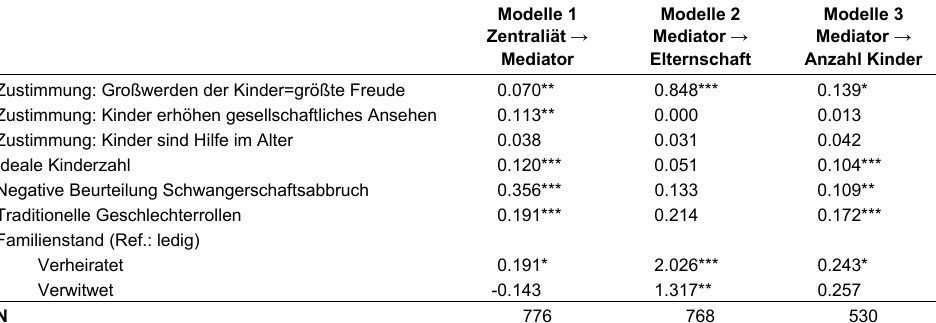
Tabelle 1 : Zentralität, Fertilität und potentielle Mediatoren